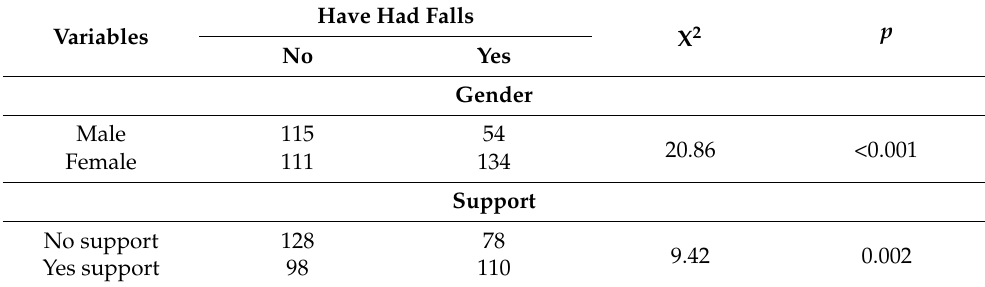
Table 4. Existence of falls based on socio-demographic variables.